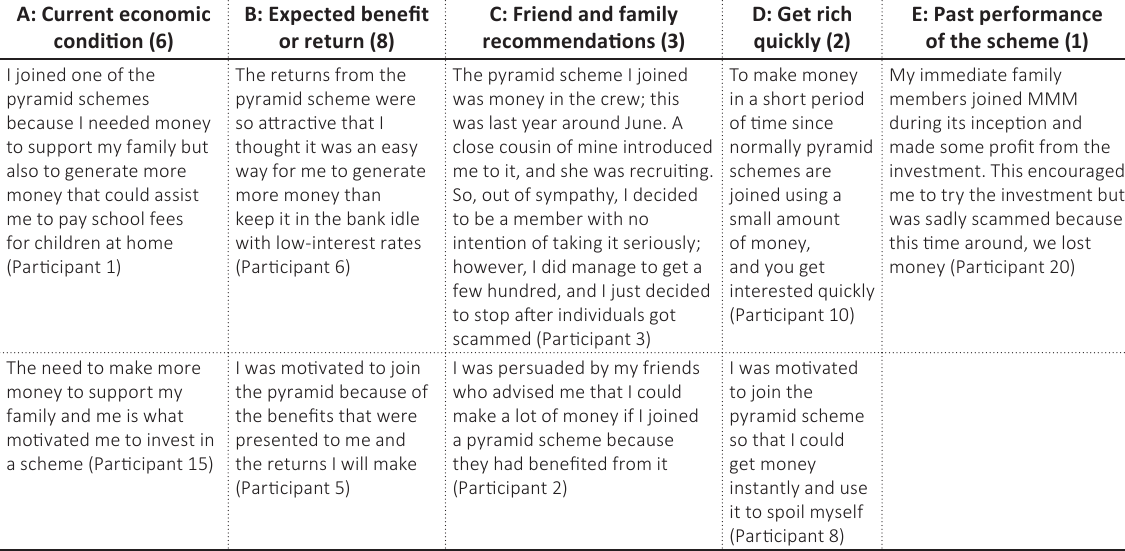
Table 2. Framework matrix on the emerging themes and